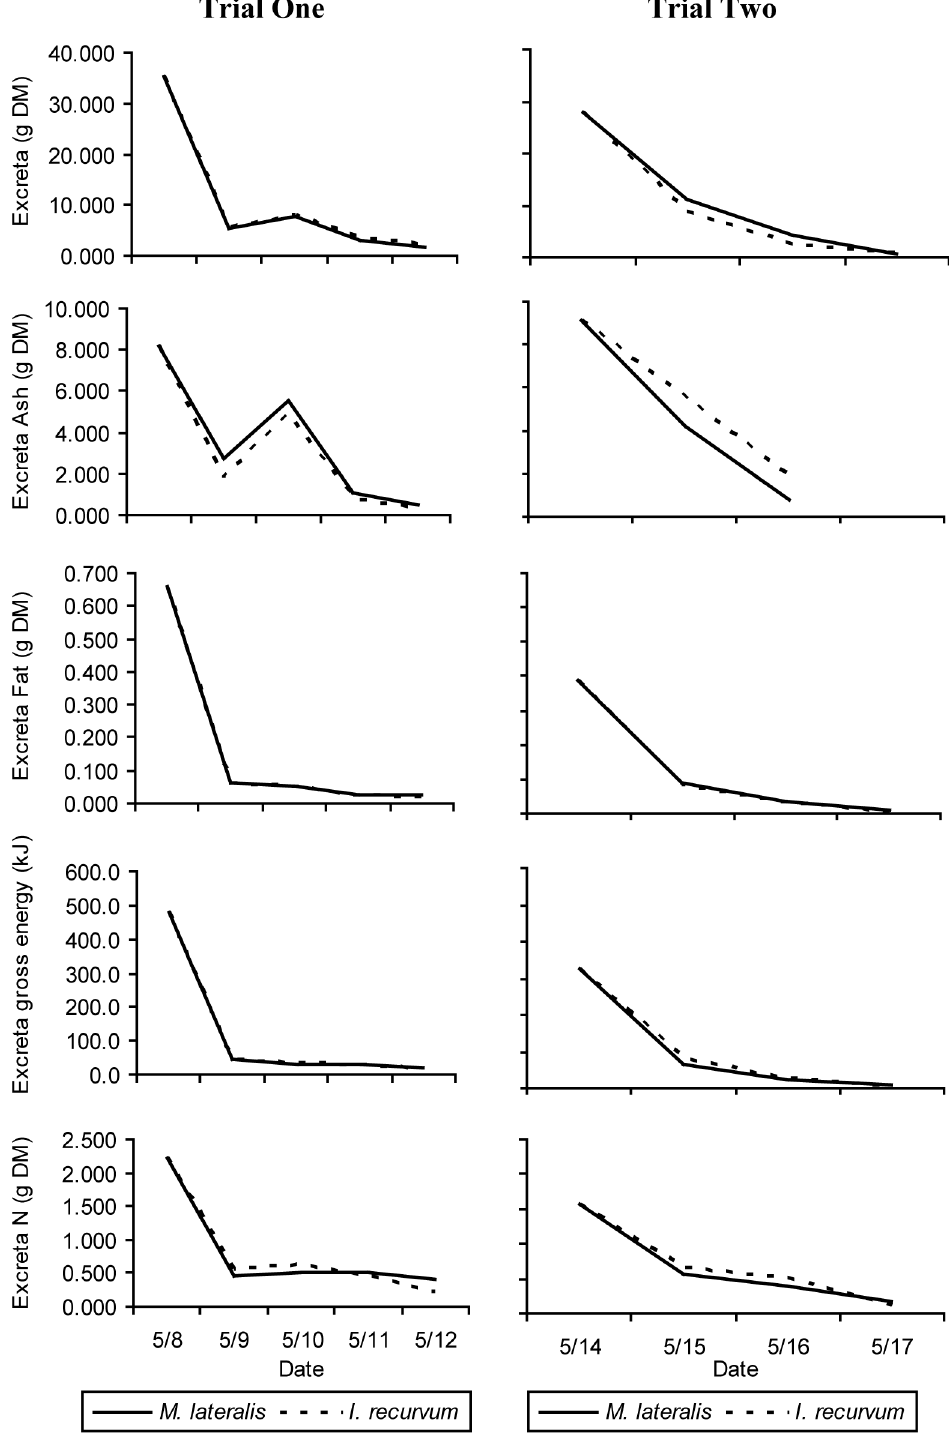
Fig 7. Excreta dry mass, ash, fat, nitrogen, and gross energy produced by surf scoters during foraging trials. The amount of excreta dry mass (g), ash (g DM), fat (g DM), nitrogen (g DM), and gross energy (kJ) produced each day during feeding trials on eight captive surf scoters fed Mulinia lateralis and Ischadium recurvum , the top two prey items obtained by wintering surf scoters in the Chesapeake Bay